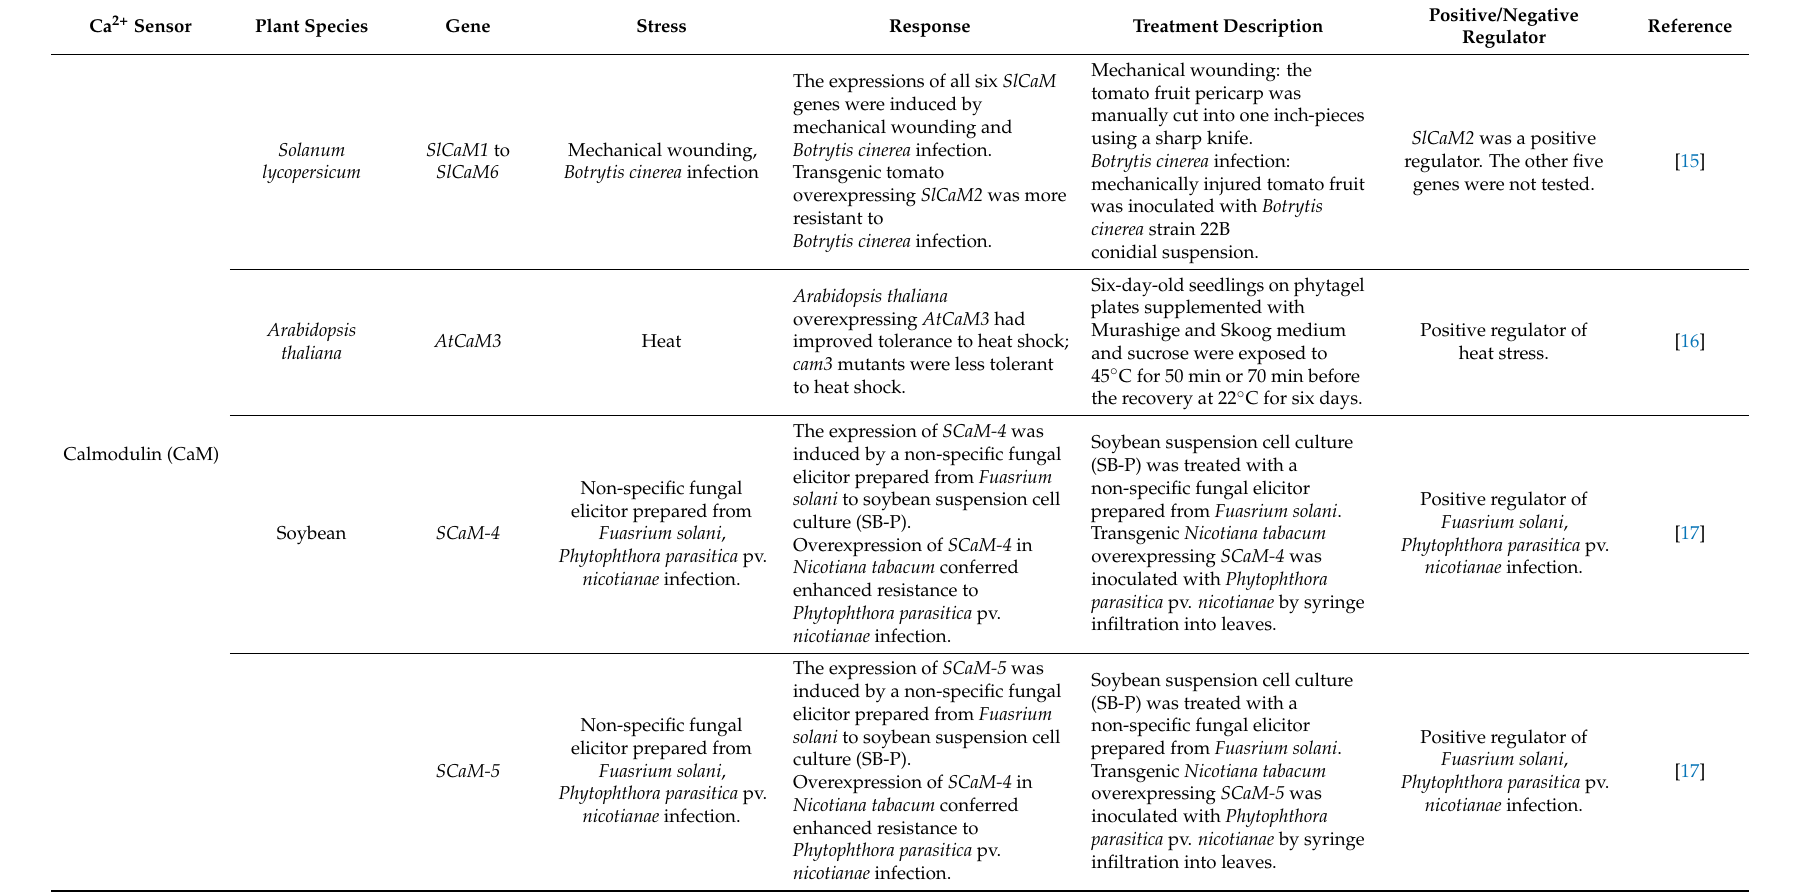
Table 1. Stress-responsive Ca 2+ sensors in